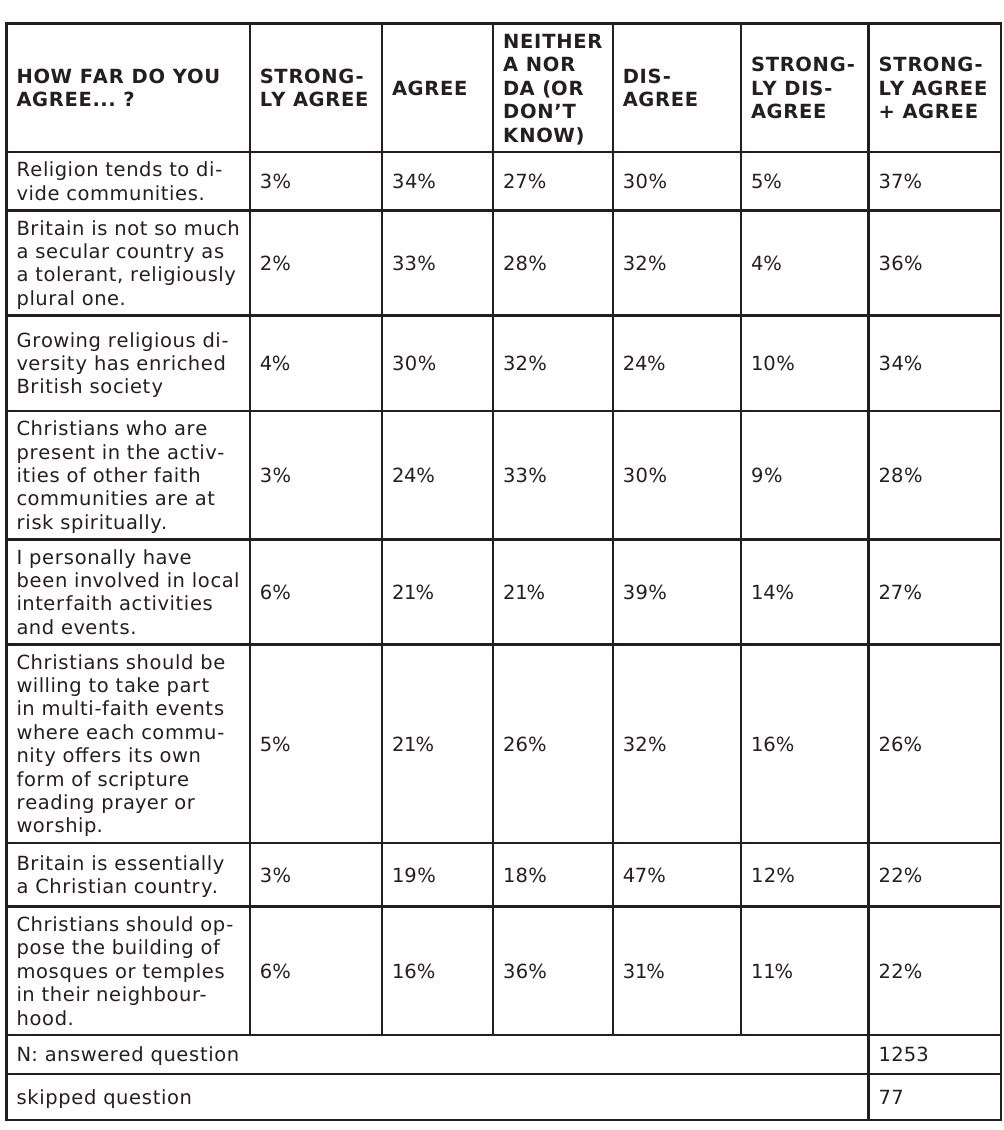
Evangelicals’ views of other